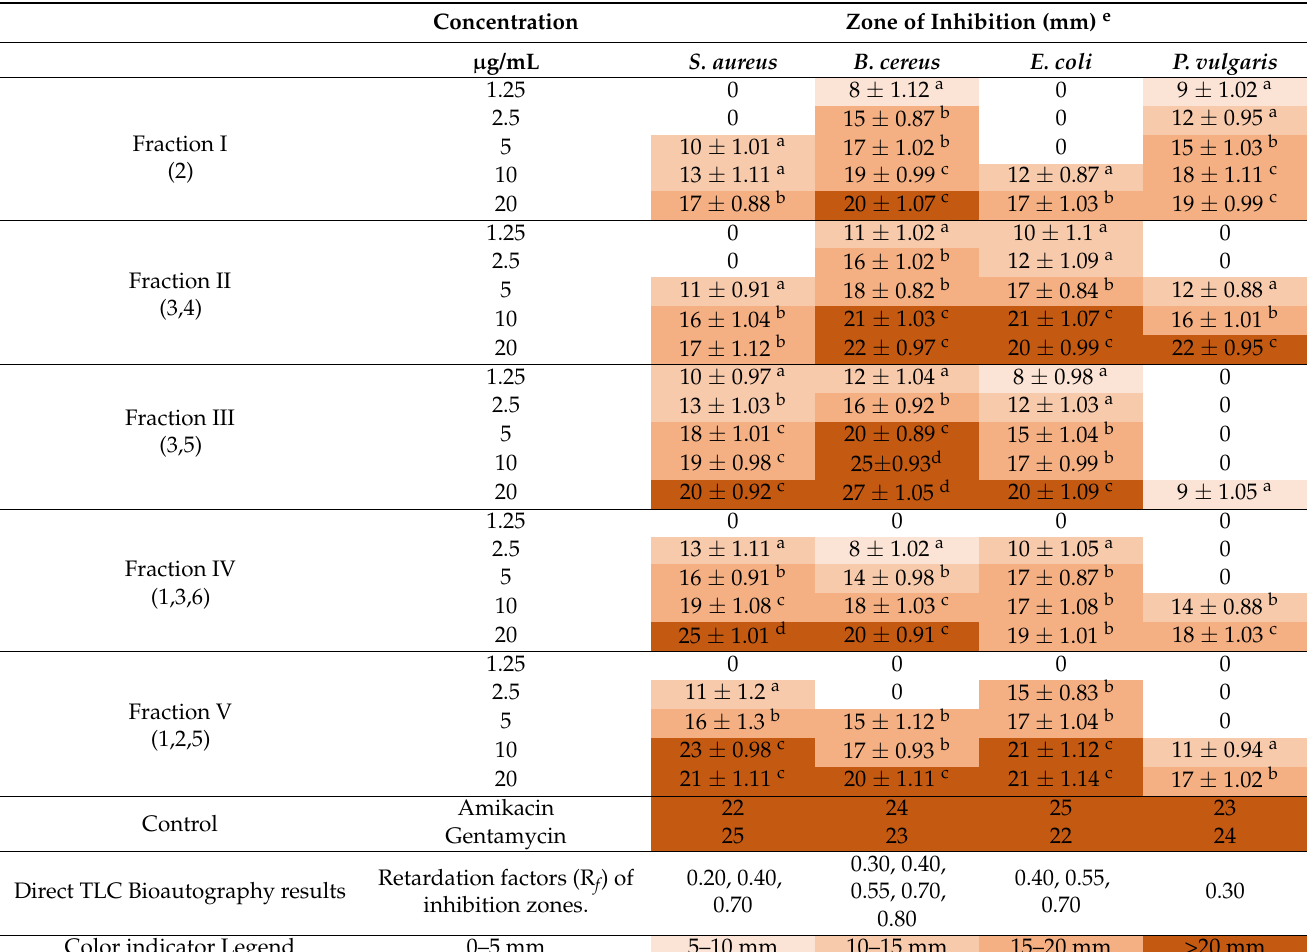
Table 2. Antimicrobial activity of fraction I–V. Concentration Zone of Inhibition (mm)